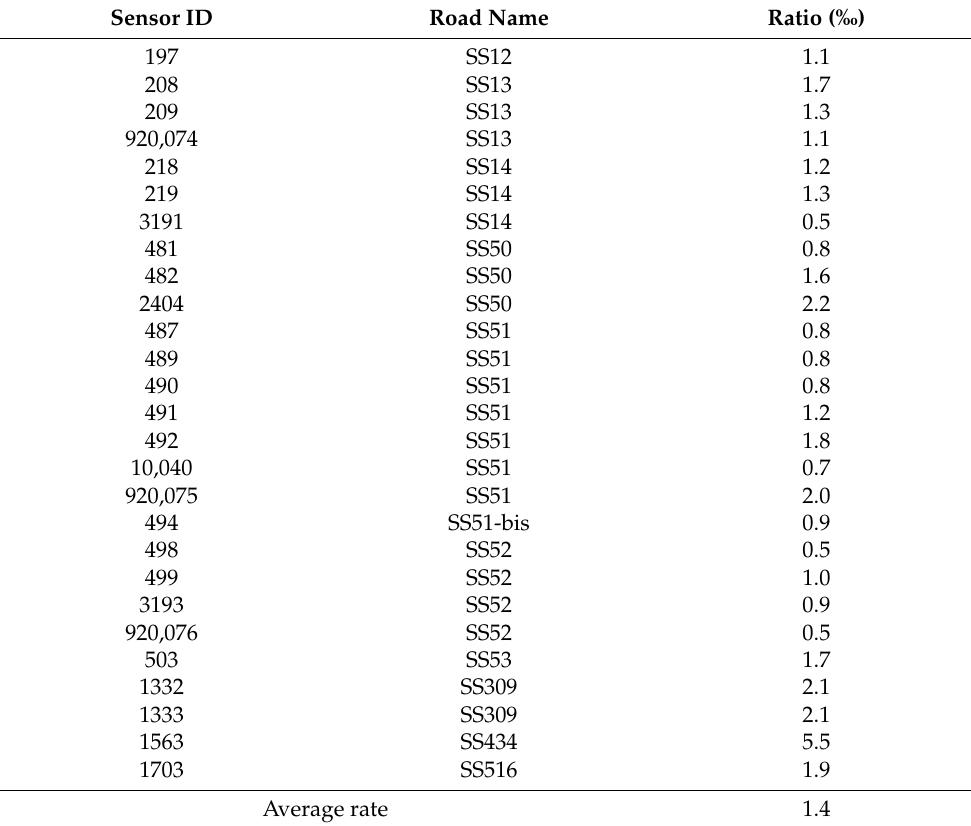
Table 4. Values of the representativeness rate of the HCD sample evaluated for each control unit. Sensor ID Road